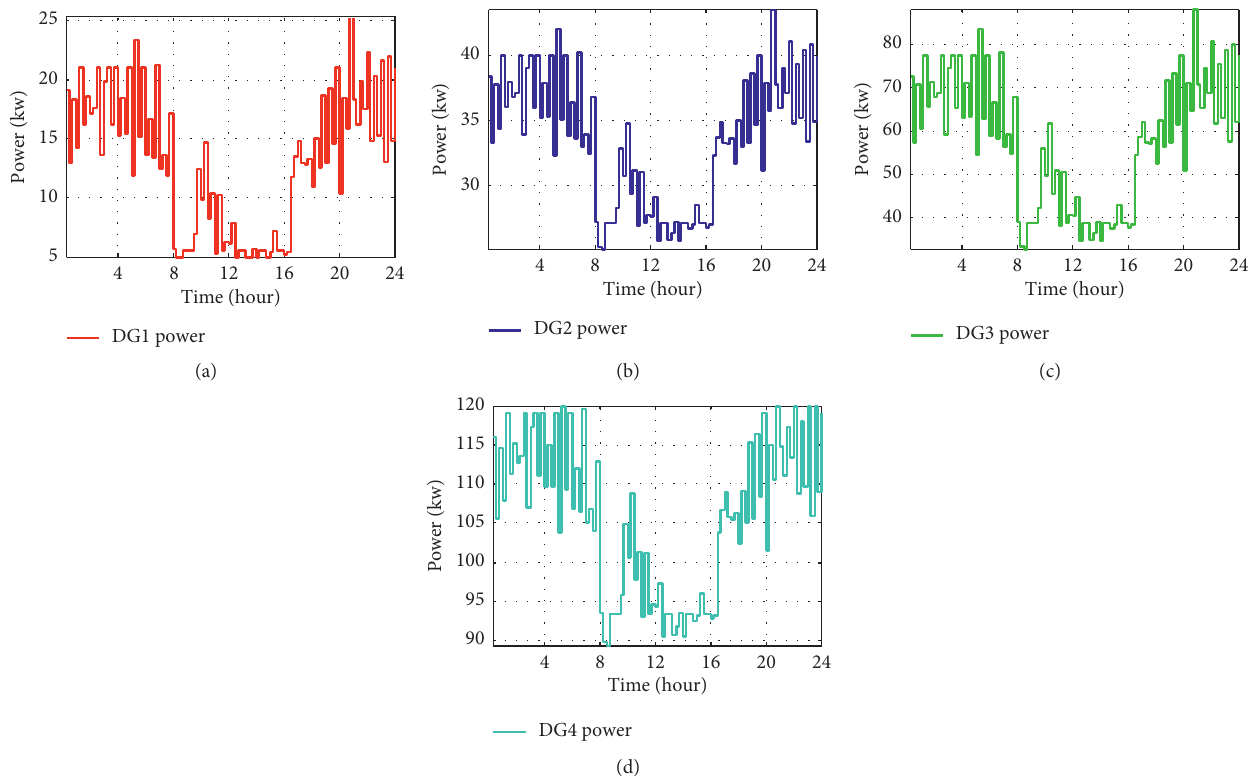
Figure 5: Operation schedule of DGs with